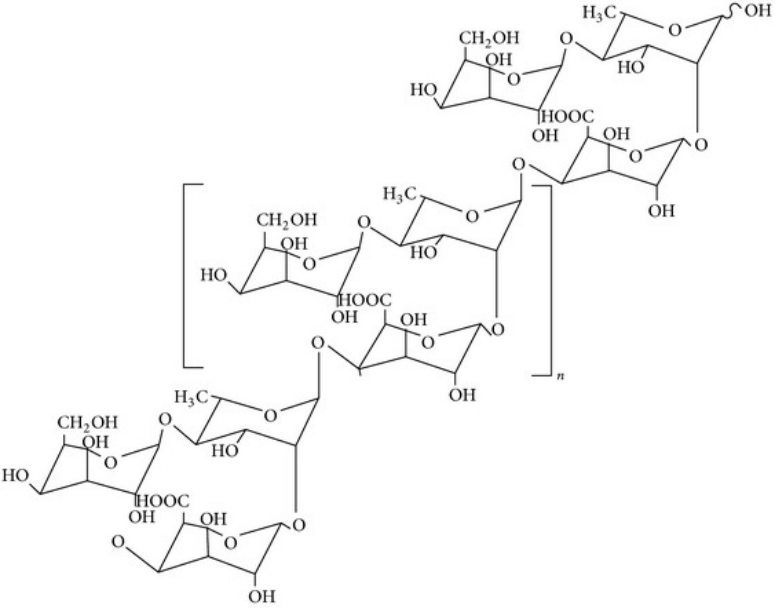
Figure 1. Structure of okra mucilage [29].